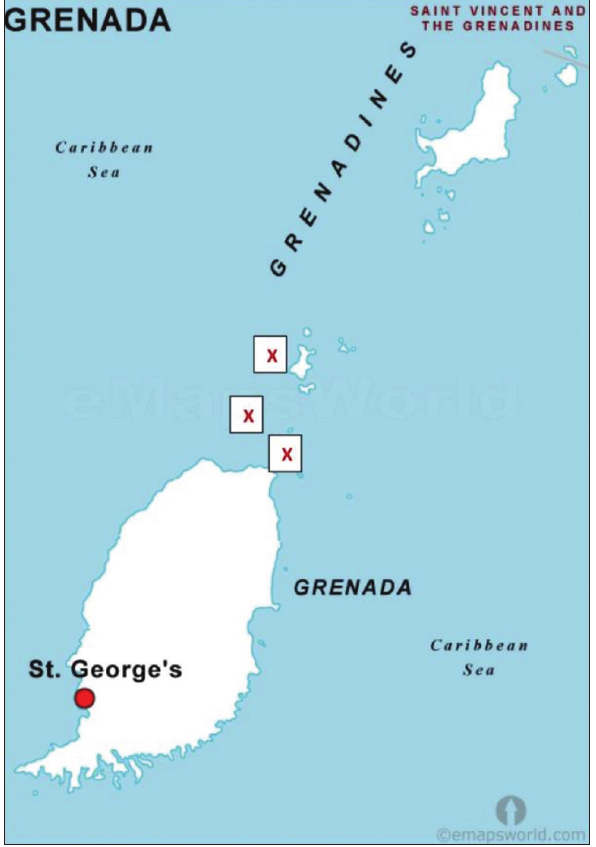
Figure-1: Map of Grenada showing sample collection sites (X). [Source: https://emapsworld.com/grenada-capital- map.html, pasted onto image by Jonnel